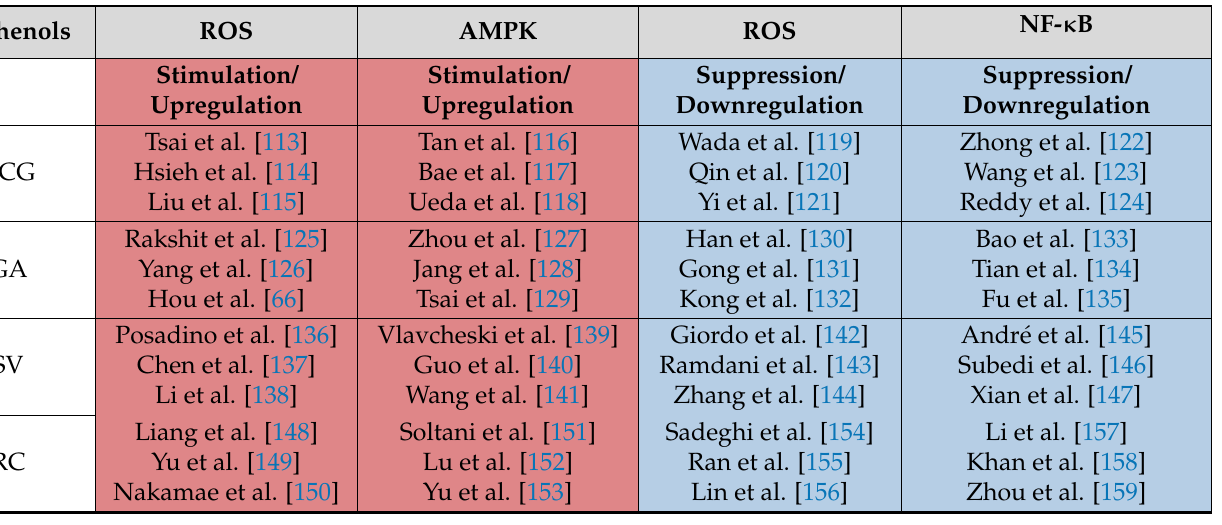
Table 1. Studies showing EGCG, CGA, RSV, and CRC modulatory effects on ROS, AMPK, and NF- κ B. Studies showing ROS and AMPK stimulation or upregulation are in red boxes, whereas studies showing ROS and NF- κ B suppression or downregulation are in blue